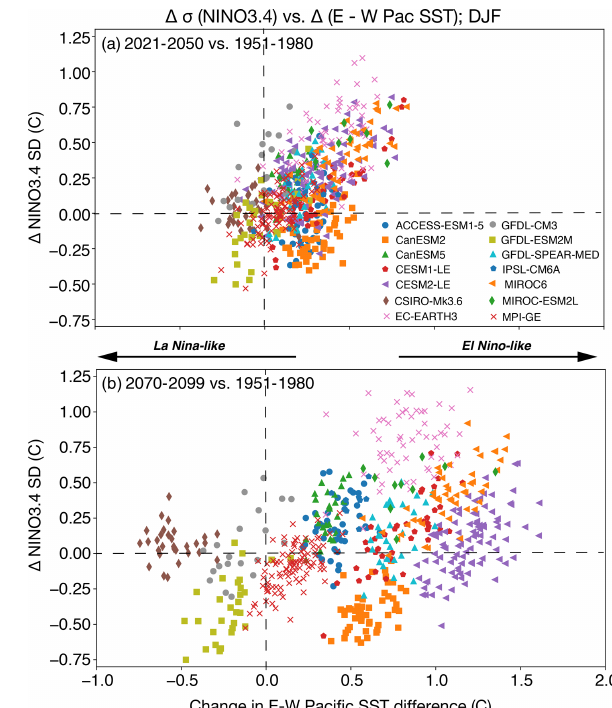
Figure 8. Time differences of the Niño3.4 standard deviation ( y axis) and the difference in SST between the eastern and west- ern equatorial Pacific (defined as in Fig. 7; x axis) for each en- semble member of the 14 SMILEs, indicated by colored symbols. (a) Difference between 2021–2050 and 1951–1980; (b) difference between 2071–2099 and 1951–1980. Niño3.4 time series are de- trended by subtraction of the time-varying ensemble mean prior to computation of the standard